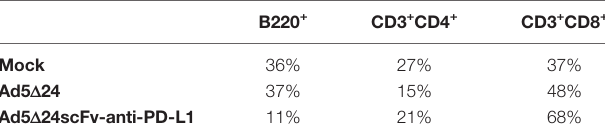
We evaluated the mean percentages of TILs population from different tumors treated with PBS (Mock), Ad5 D 24, or Ad5 D 24 anti-PD-L1-scFv. In the groups of animals that received the Ad5 D 24 anti-PD-L1-scFv was observed an enhancement of the CD3 + CD8 + T-cell population. In fact, as can be seen from the table the percentage of CD3 + CD8 + T-cell population in the tumors treated with Ad5 D 24 anti-PD-L1-scFv is 68% compared with 48 and 37% of Ad5 D 24 and Mock,